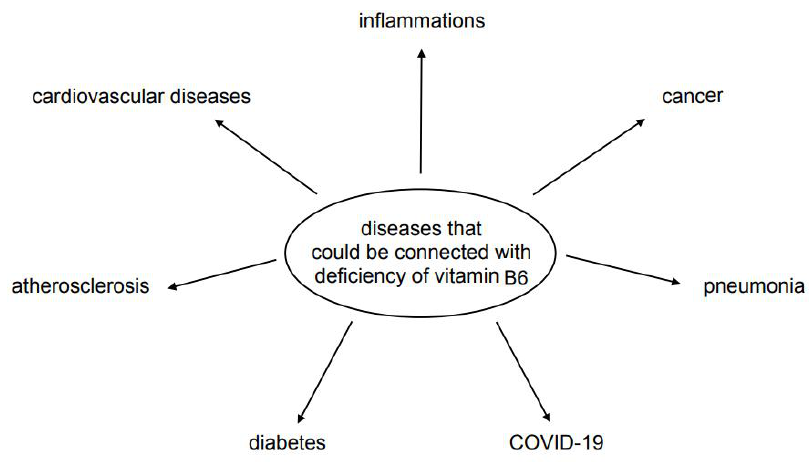
Figure 4. Possible diseases related to vitamin B6 deficiency.